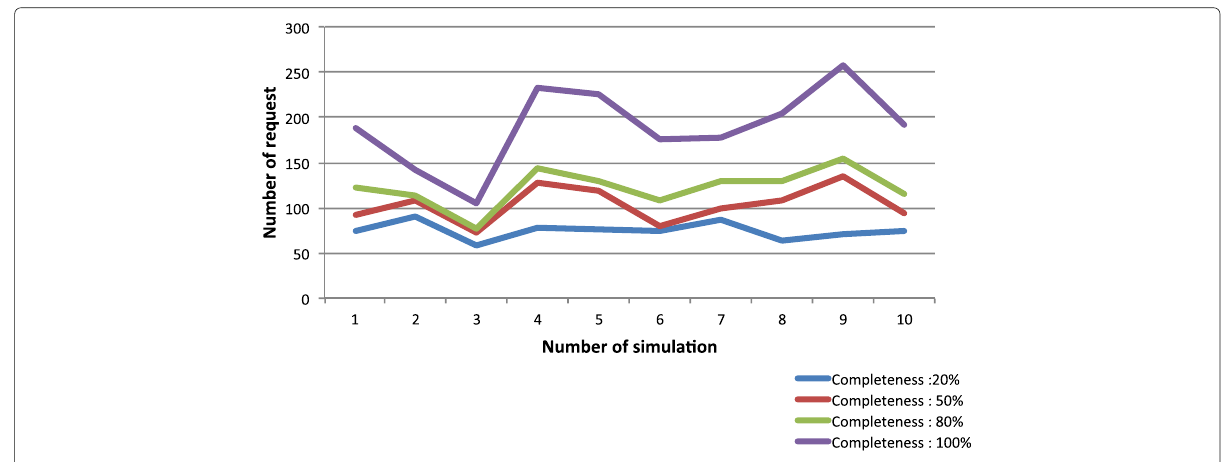
learning and how the level of completeness